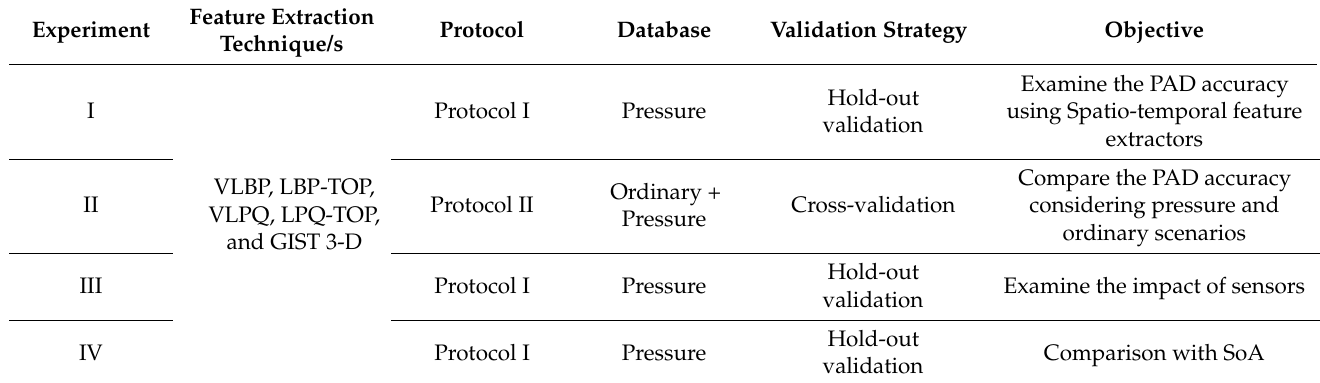
Table 7. Summary of the proposed experiments.